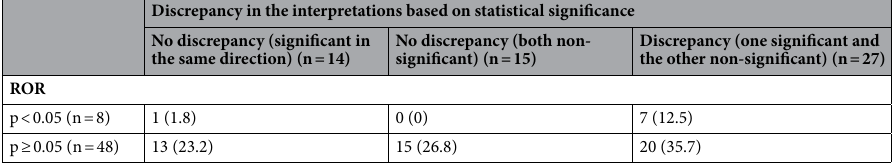
Discrepancy in the interpretations based on statistical significance No discrepancy (significant in No discrepancy (both non- Discrepancy (one significant and the same direction) (n = 14) significant) (n = 15) the other non-significant) (n =